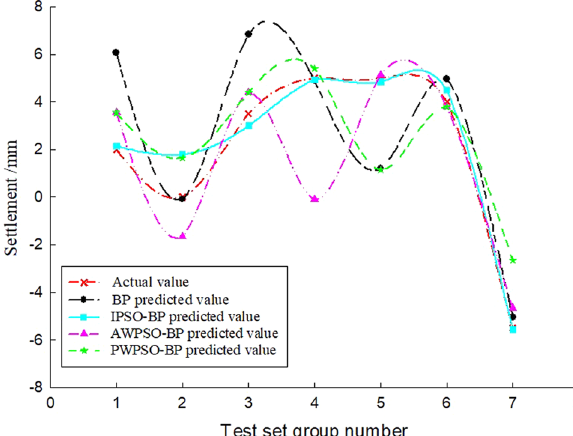
Figure 9. Right Y3 measuring point.